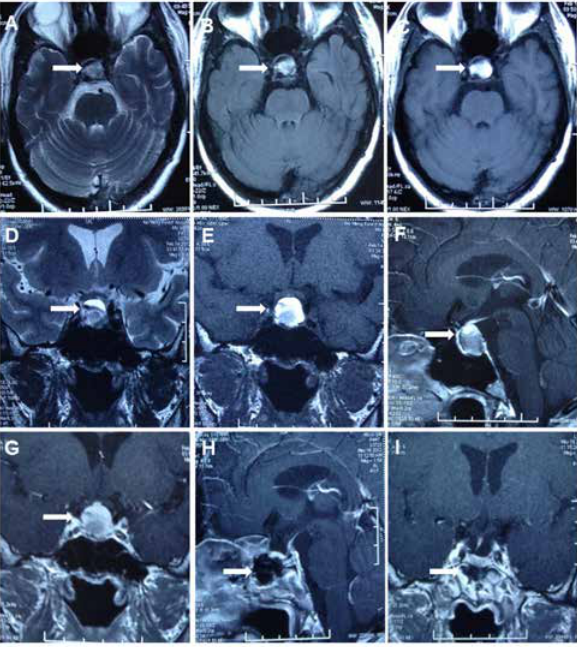
Figure 1: Pre- and post-operative brain MRI. (A) Axial T2 - weighted image. (B) Axial FLAIR T2 - weighted image. (C) Axial T1 - weighted image. (D) Coronal T2 - weighted image. (E) Coronal T1 - weighted image. (F) Enhanced sagittal T1-weighted image. (G) Enhanced coronal T1 - weighted image. (H) Post-operative enhanced sagittal T1-weighted image. (I) Post-operative enhanced coronal T1 - weigh- ted image.